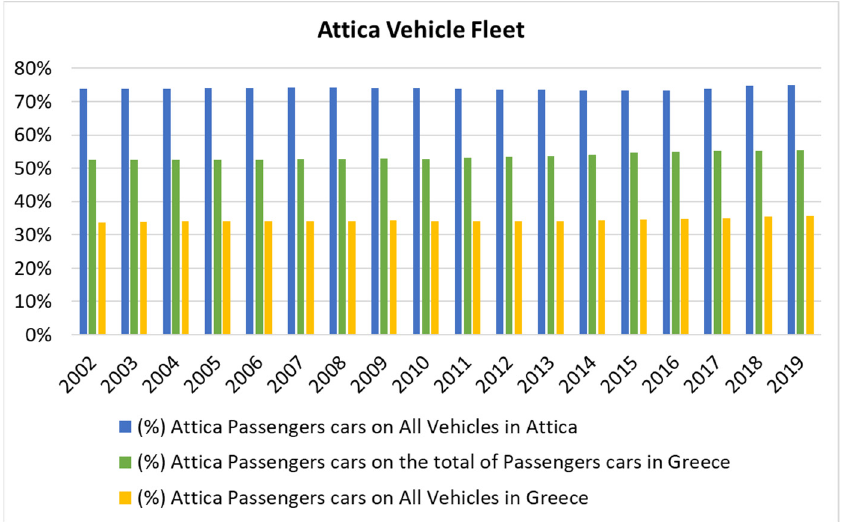
Figure 3. Percentage ratio of passenger vehicles in Attica, to the total number of vehicles in Attica, Greece and passenger vehicles in Greece. Greece and passenger vehicles in